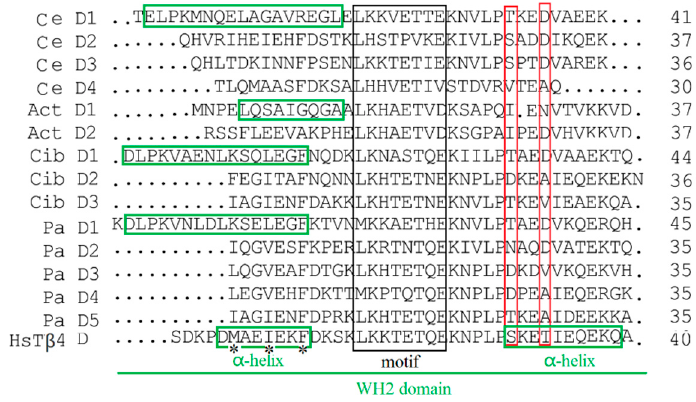
Figure 2. Function domains analysis of thymosins. Alignment of five Pa-THYs domains with the other four thymosins from different species (Ciboulot (Cib D, three), Actobidin (Act D, two), tetra thymosin β (Ce D, four), and human thymosin β 4 (HsT β 4 D, one)). α -helix, motif sequences, and function residues were marked by green, black and red rectangle, respectively.